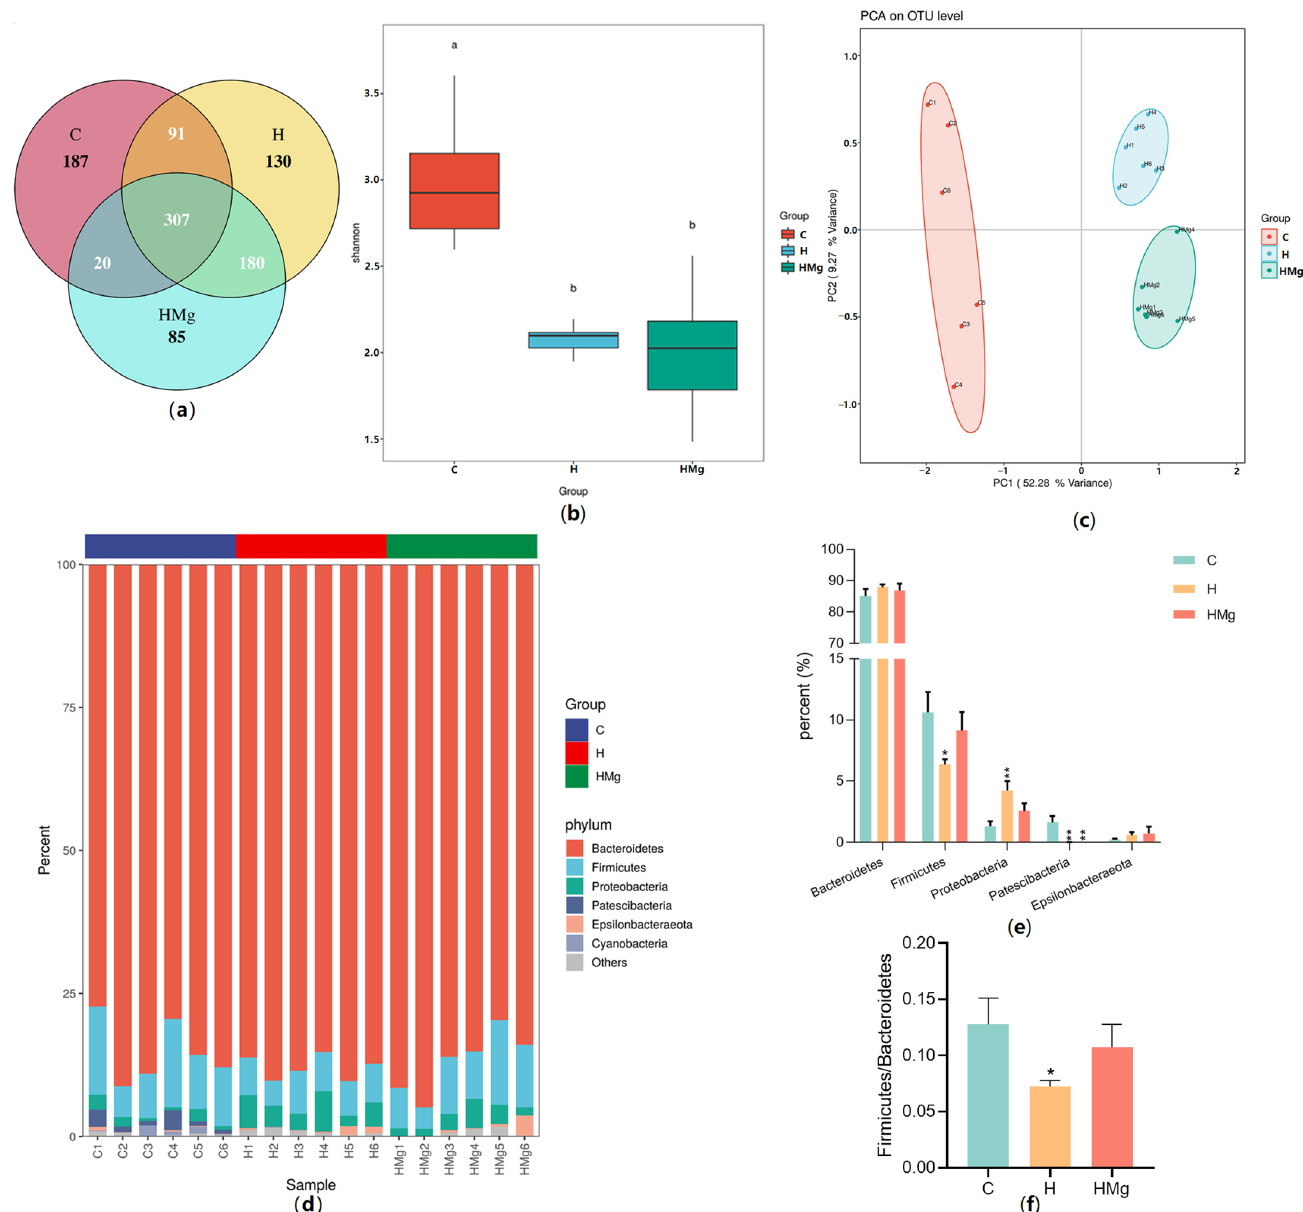
Figure 2. MgIG modifies HRZE-induced gut microbiota composition. ( a ) Venn diagram of the operational taxonomic unit (OTU) distribution; ( b ) the Shannon index of α -diversity-there are significant letters above each group, and there is a statistical difference between different letters ( p < 0.05); ( c ) principal component analysis (PCA) of β diversity; ( d , e ) species composition analysis at the phylum level; ( f ) the abundance ratio of Firmicutes to Bacteroidetes (F/B). The data are presented as the means ± SEM ( n = 6). Compared with the control group: * p < 0.05 and ** p < 0.01. Abbreviations: C, control group; H, HRZE group; HMg, HRZE + MgIG